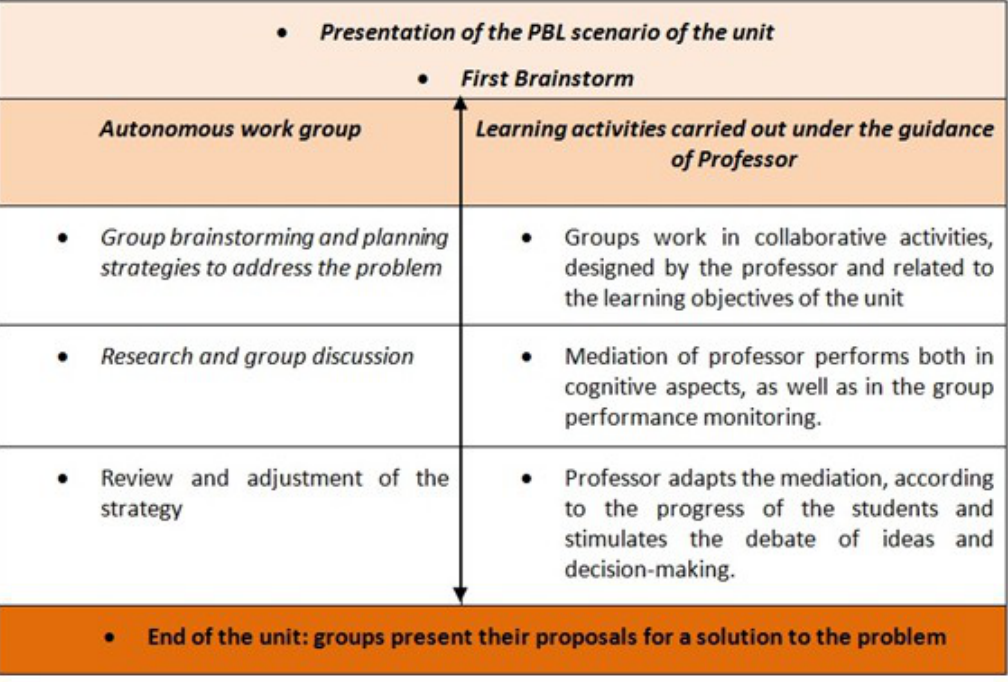
Figure 1. Hybrid PBL approach implemented in the General Chemistry